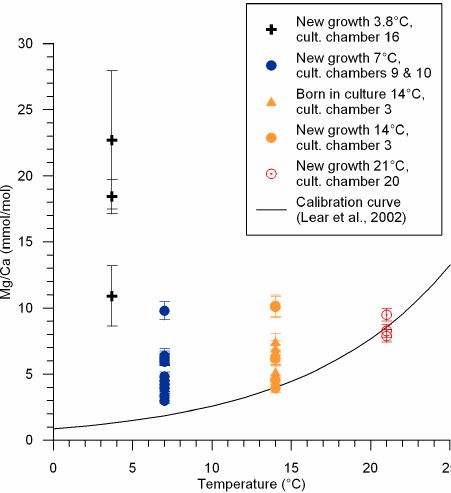
Fig. 9. Mg distribution coefficients plotted versus length from the proloculus to LA raster, presented together with the data from Hintz et al. (2006a) study of ontogenetic effects on Mg/Ca of B. aculeata . D Mg for the cultured foraminifera from the present study was cal- culated assuming a sea water Mg/Ca ratio of